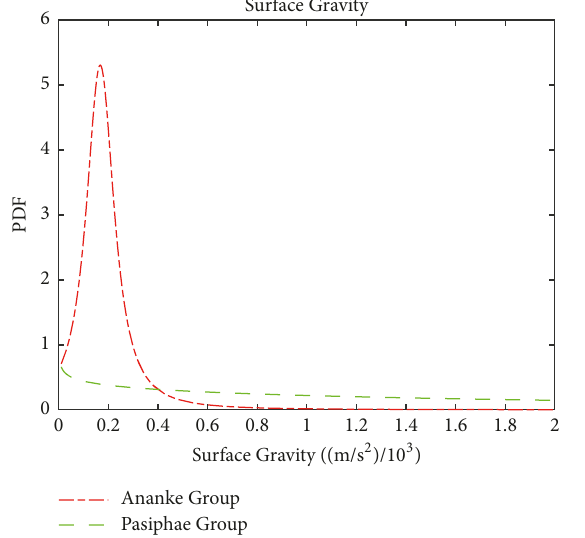
Figure 7: The PDF curves of surface gravity.